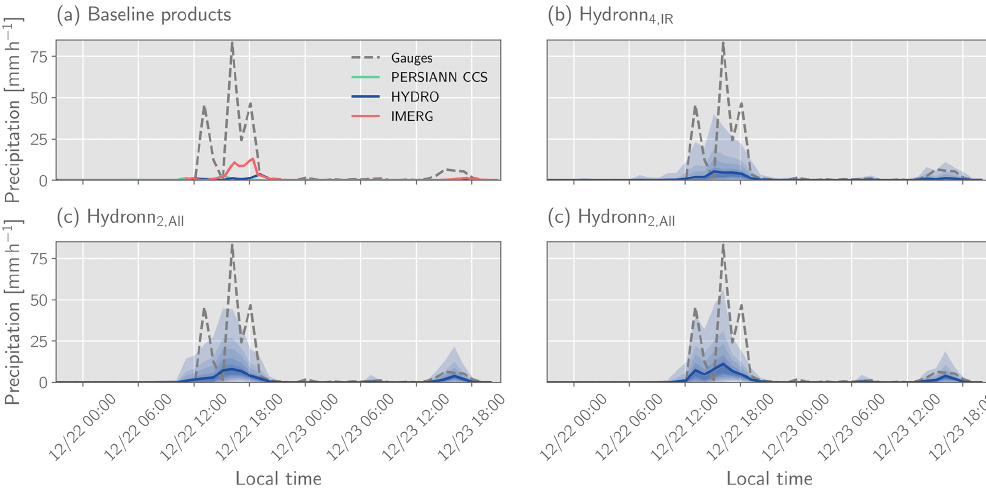
Figure 19. Retrieved precipitation for an extreme precipitation event that occurred between 22 and 24 December 2020, in the city of Duque de Caxias in the state of Rio de Janeiro. Dashed grey lines show the precipitation at the gauge station in Xerém. Solid lines show the retrieved mean precipitation for each retrieval algorithm. The shading shows filled contours of the posterior CDF at values [0.01, 0.1, 0.2, ..., 0.8, 0.9,